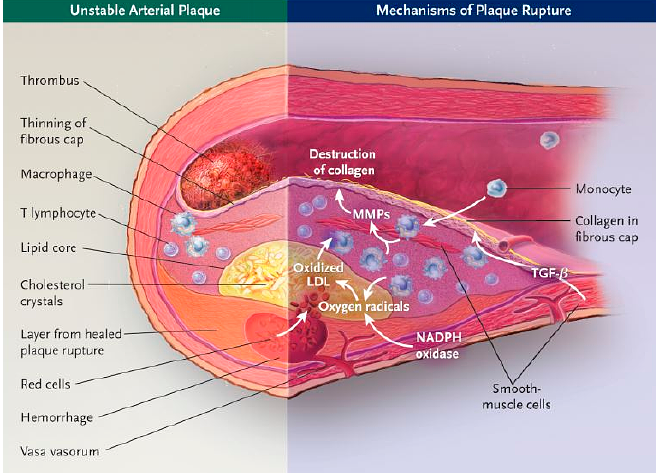
Figure 1. Pathogenesis of atherosclerosis and the mechanisms of plaque rupture. Unstable plaque has a thin fibrous cap, may be thrombotic, and is characterized by many inflammatory cells and a large lipid core. Accumulation of macrophages and T lymphocytes in plaques leads to the release of matrix metalloproteinases (MMPs), which digest collagen and cause thinning of the fibrous cap. The necrotic lipid core grows as a result of the accumulation of lipids in the extracellular matrix, the death of lipid-laden macrophages, and perhaps the accumulation of erythrocyte membranes after intraplaque hemorrhage from the vasa vasorum. Oxygen radicals, generated mainly from NADPH oxidase and inflammatory cells, oxidize low-density lipoproteins (LDL) and cause necrosis of cells. (Reprinted from Reference [61]. Copyright with permission from © 2003, Massachusetts Medical Society.) Stage I lesions consist of the focal accumulation of lipids with slight intimal thickening. The progression to stage II involves the infiltration of lymphocytes and macrophages, with the latter referred to as “foam cells”, due to the intracytoplasmic lipidic inclusions. This type of lesion, defined as a “fatty streak”, appears as a yellowish stripe on the intimal surface and is a common feature in the aortas of both ApoE − / − and LDL − / − mice. The accumulation of extracellular lipids is detected in lesions that undergo progression to stage III. The first lesion considered advanced by histological criteria is stage IV, presenting a further increase and convergence of extracellular lipids to form a “lipid core” covered with foam cells. Afterwards, a “cap” of fibrous tissue progressively develops, and thus the stage V lesions are defined as “fibrous plaques”. Macrophage-derived foam cells and lymphocytes are generally found densely concentrated along the periphery of the lipid core of both stage IV and V lesions [62,63]. Stage IV and V lesions are capable of developing fissures, hematomas, and/or thrombi and, for this reason, are clinically relevant in terms of morbidity and mortality in humans. Finally, plaques called “complicated” correspond to stage VI, because these lesions are characterized by ulcerations, hematomas, hemorrhages or thrombi, and may generate acute events. Although both mouse models develop atherosclerotic plaques at the level of the aorta after being fed a high-fat diet which closely resemble the morphological features of human atherosclerotic plaques, ApoE − / − mice develop more extended lesions in a shorter time frame [55,57,64]. Moreover, the atherosclerotic plaques have been described in ApoE − / − mice not only in the aortic root but throughout the entire aorta (descending thoracic and lower abdominal aorta, aortic